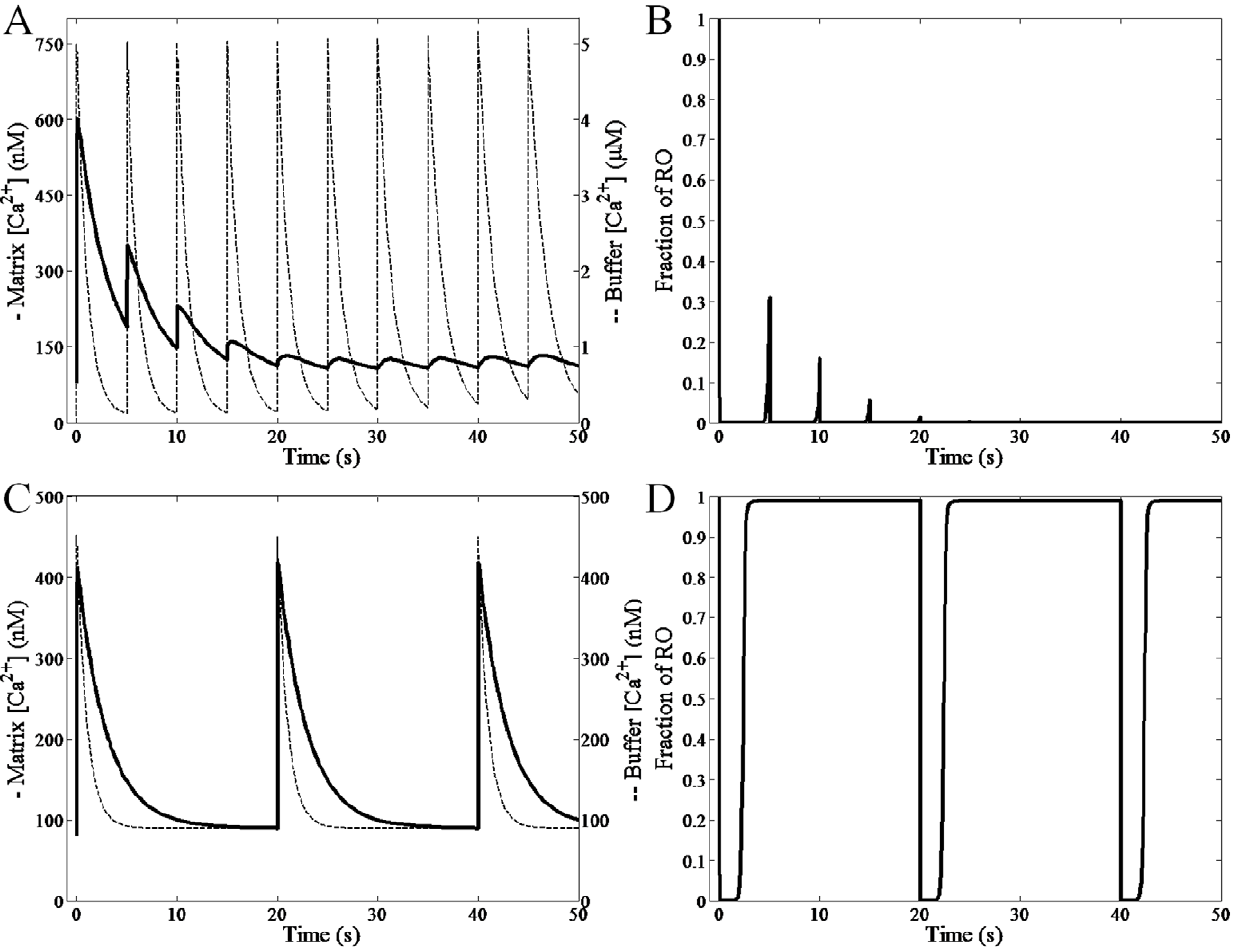
Figure 5. Corroboration simulations for the RaM model. The experimental conditions outlined in [14] were simulated using the extremely simplified Ca 2 + model described in the Material and Methods. A) The matrix and buffer Ca 2 + dynamics were simulated for the high amplitude and frequency experiment. B) The corresponding fraction of RaM in the RO state is shown. C) The matrix and buffer Ca 2 + dynamics were simulated for the low amplitude and frequency experiment. B) The corresponding fraction of RaM in the RO state is